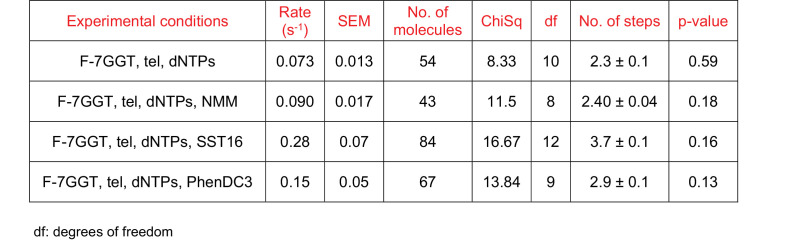
Curve fitting parameters of the curves in Figure 9K.